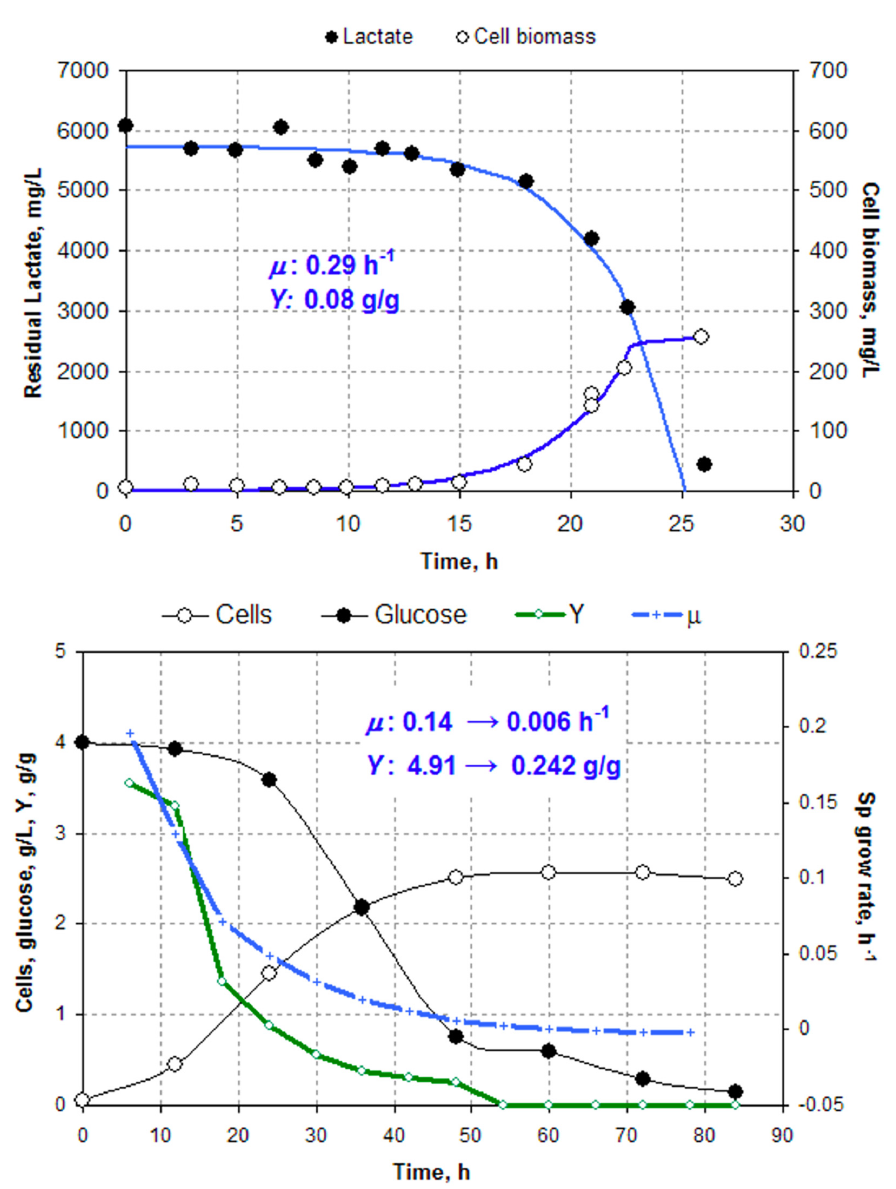
Figure 2. Experimental validation of FBA. Top: M. elsdenii growth on complex medium [18]. Bottom: the minimal medium with lactate [5]. Curves were calculated from Equation (3).